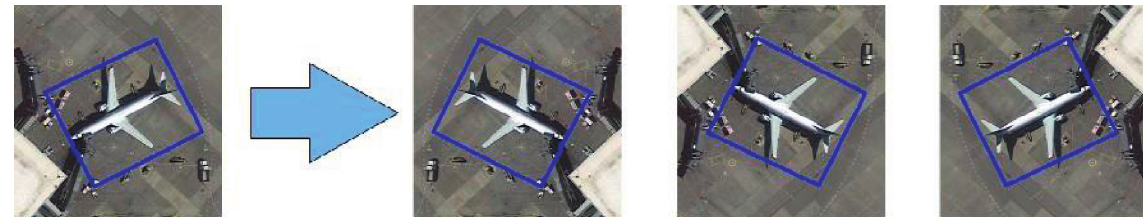
Figure 5: Data augmentation